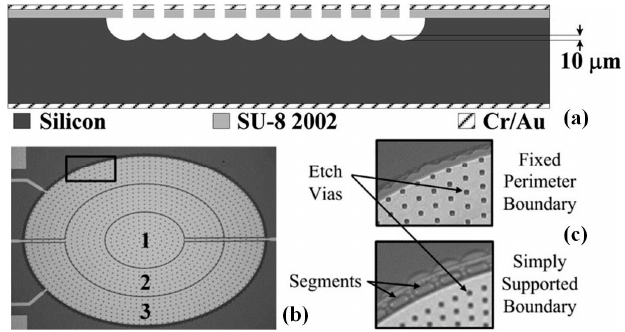
Figure 13. Micromachined deformable membrane mirrors for confocal microscope. ( a ) Cross section of the process-3 SU-8 2002 mirrors, which are dry etch released in XeF2: 2.5 µm of SU-8 2002 is photopatterned; 60-Å chrome and 150-nm gold are evaporated as a reflective coating and to form the top electrodes, patterned using a liftoff process; 60-Å chrome and 200-nm gold are evaporated onto the backside for the silicon counter electrode; and an air gap is created by dry etching the silicon through the small vias. ( b ) Top view of a 2 mm × 2.8 mm elliptical boundary mirror with the three electrodes labeled; ( c ) Smaller section of the mirror with either a fixed perimeter boundary or with 20% duty width segments in the membrane layer to emulate a simply supported boundary, and 3- or 5-µm square vias allow etchants to release the mirrors (Reproduced with permission from IEEE [88]).